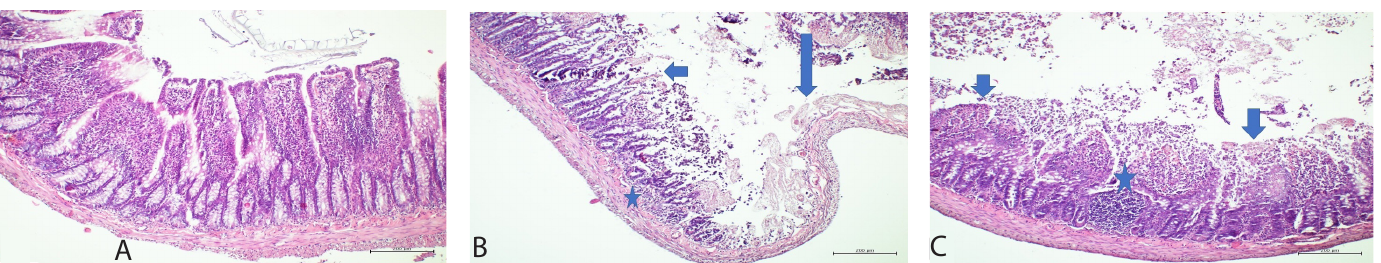
Fig. 5 - Representative histological samples of ileal tissue. Photomicrographs of ileal tissue samples (100x magnification, H-E staining). A) Control group. B) IR group. C) Probiotic group. The long arrow points to areas of ulceration and tissue damage, the short arrow points to reduction of villus height and the points asterisk to inflammatory cells.